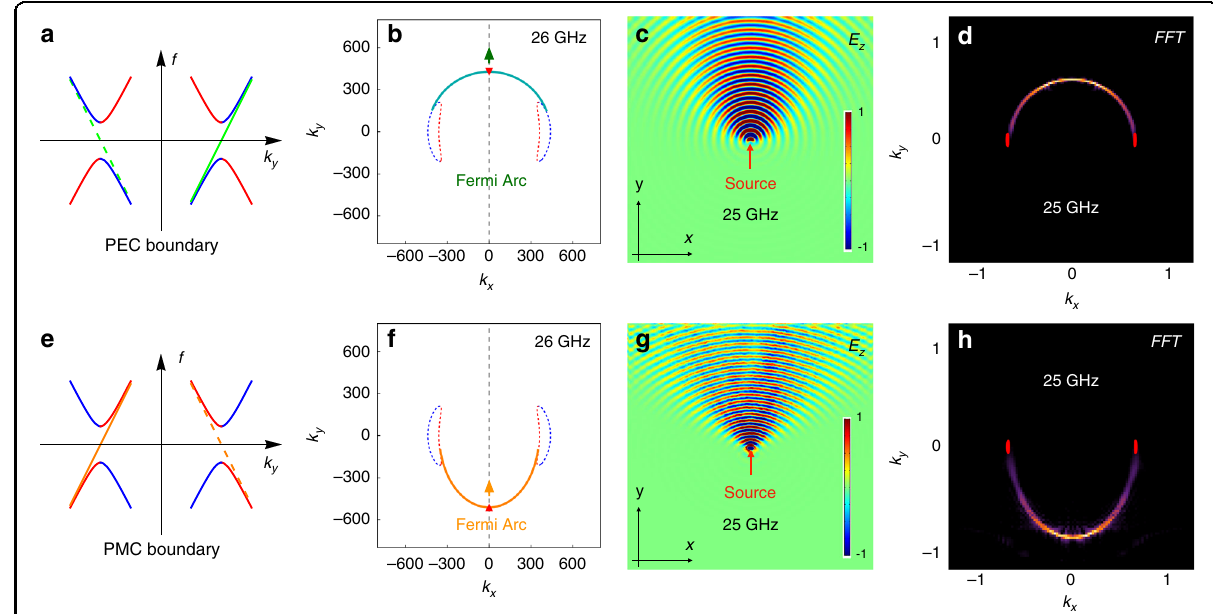
Fig. 3 Semicircular surface Fermi arcs in the minimal ideal Weyl system. a Schematic dispersion of surface states obtained at the PEC boundary of the Weyl material. Solid and dashed green dispersion lines represent the evanescent (physical) and growing (unphysical) surface states, respectively. The bulk TE mode and LP mode are marked in blue and red, respectively. b Expected surface Fermi arc (green curve) under the PEC boundary condition. Red and blue dotted lines show the projected EFCs of bulk states at the same frequency (26 GHz). Colored arrow shows the direction of group velocity of the representative mode (red triangle). c Distribution of electric fi eld Re ( E Z ) of the surface wave at the interface between a PEC and the Weyl metamaterial, excited by a point source at 25 GHz. d Simulated semicircular EFC of surface states (Fermi arc) in the momentum space obtained by Fourier transformation ( k x and k y are scaled with k 0 ¼ 2 π m (cid:2) 1 ). e – h Same as a – d but for the PMC boundary. The evanescent 5 ´ 10 (cid:2) 3 (physical) and growing (unphysical) surface stat e s are plotted in solid and dashed orange lines in e ,